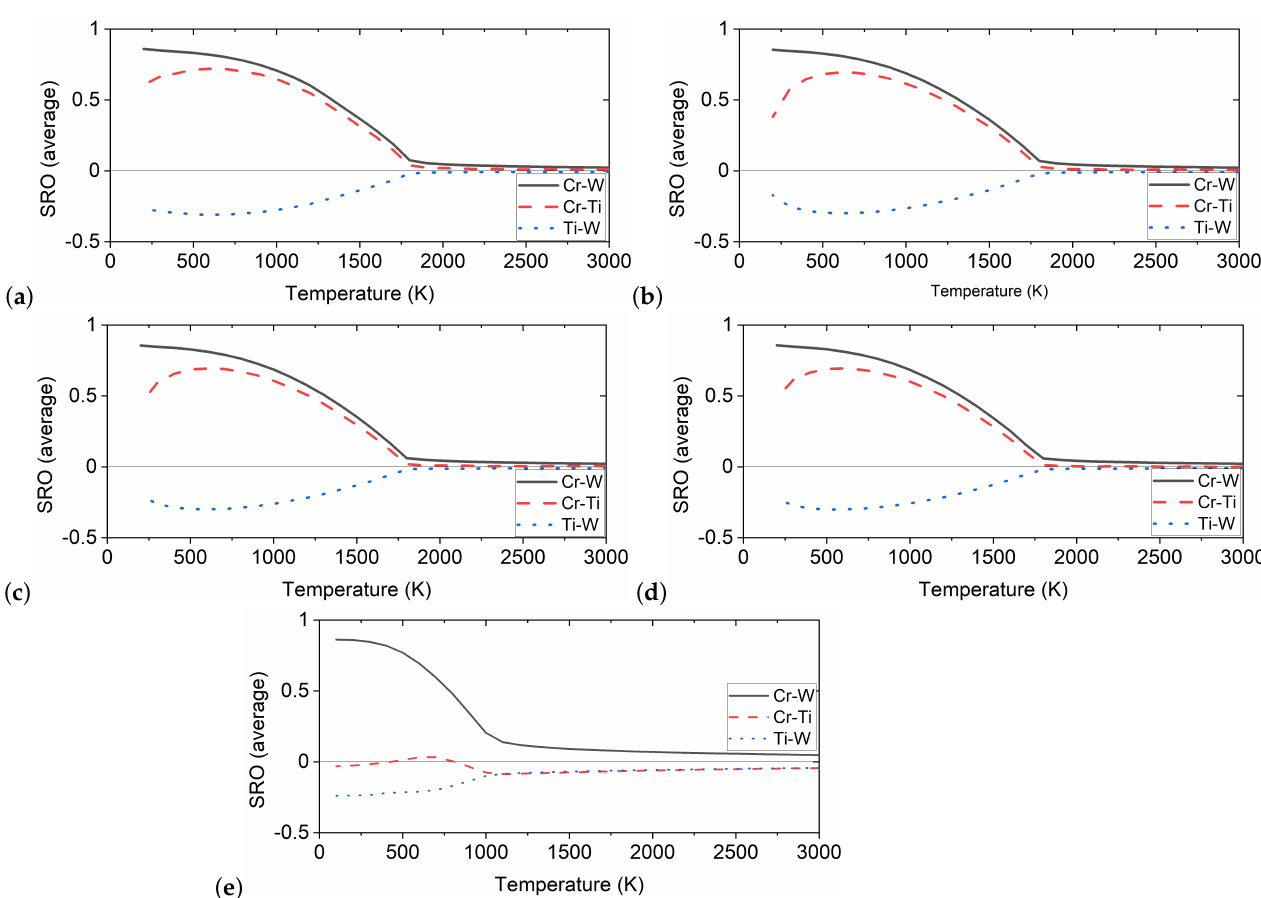
Figure 12. Average short-range order parameters for ternary ( a ) W 70 Cr 29.5 Ti 0.5 , ( b ) W 70 Cr 29 Ti 1 , ( c ) W 70 Cr 28.5 Ti 1.5 , ( d ) W 70 Cr 28 Ti 2 , and ( e ) WCrTi alloys.